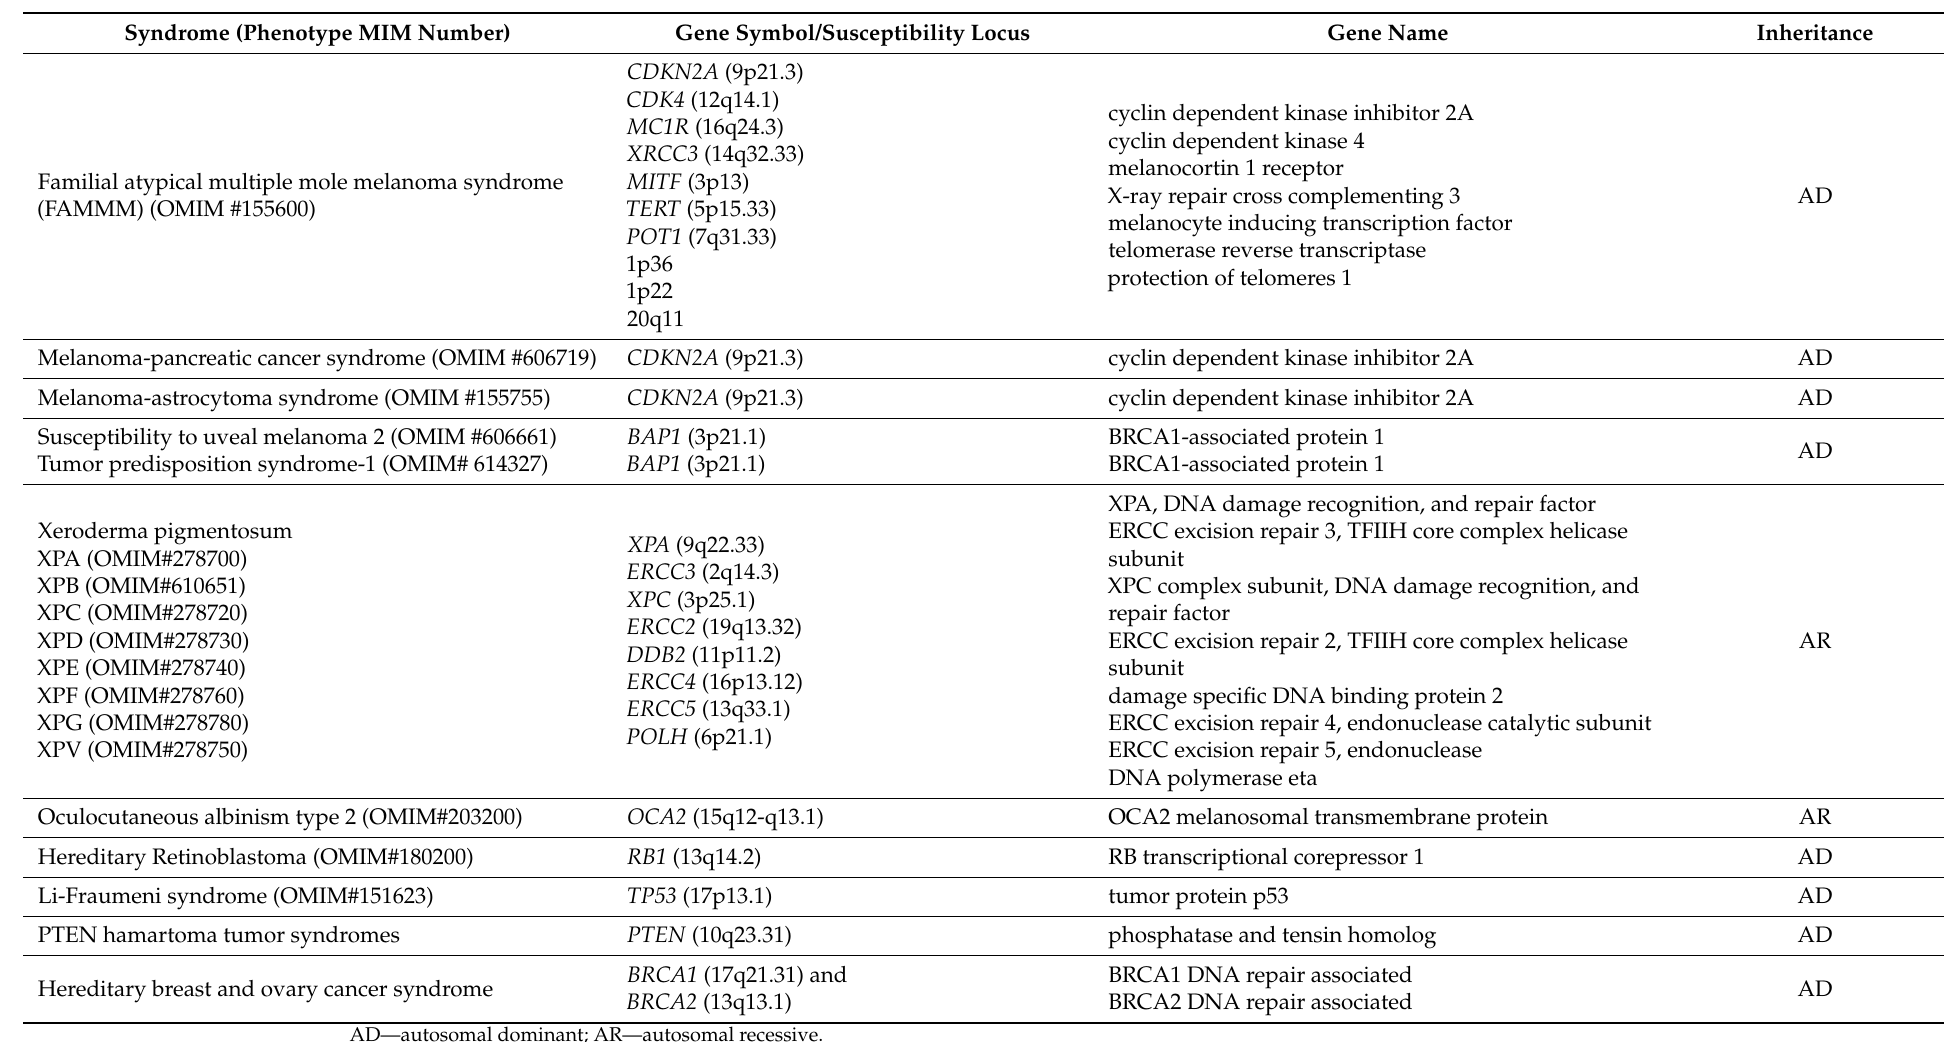
Table 2. Syndromes with predisposition to cancer and risk for melanoma and their related genes/susceptibility locus